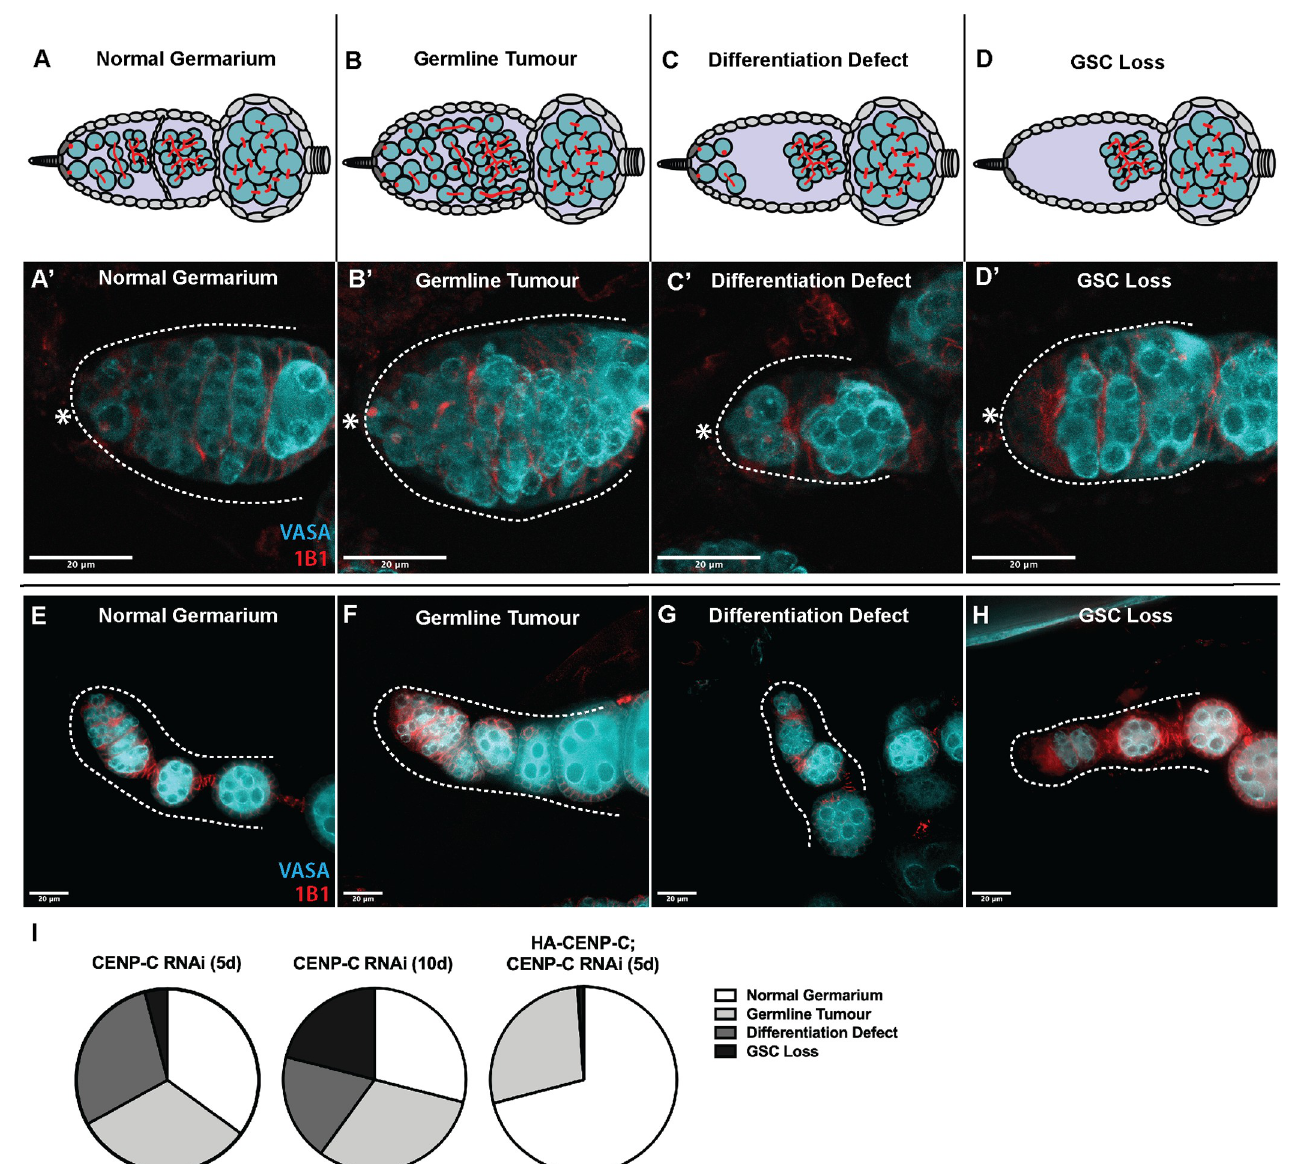
Fig 4. CENP-C depletion disrupts GSC proliferation and maintenance over time. (A-D) Characterisation of the phenotypes arising in CENP-C depleted germaria. (A, A’) Normal germarium are healthy with the expected lineage of germ cysts and spectrosome/fusome development. (B, B’) Germline tumours are characterised by an increased number of germ cells (GSCs, CBs, cysts) in the germaria, often displaced from their normal position with abnormal spectrosome/ fusome morphology. (C, C’) The differentiation defect is characterised by a pool of GSCs/CBs in the apical end of the germaria, separated from later stage developing cysts. (D, D’) GSC loss is characterised by the absence of GSCs (and often CBs and early germ cysts) at the apical end of the germarium. � denotes cap cells. Scale bar = 20 μ m. Continued egg chamber development in CENP-C RNAi ovarioles displaying normal germaria (E), germline tumours (F), differentiation defects (G) or GSC loss (H). Scale bar = 20 μ m. (I) Quantitation of the frequency of the above phenotypes observed in germaria at 5-days (5d) and 10-days (10d) post-eclosion, and in the HA-CENP-C; CENP-C RNAi rescue at 5-days (5d) post-eclosion. Charts each represent 3 biological replicates (50 germaria analysed per